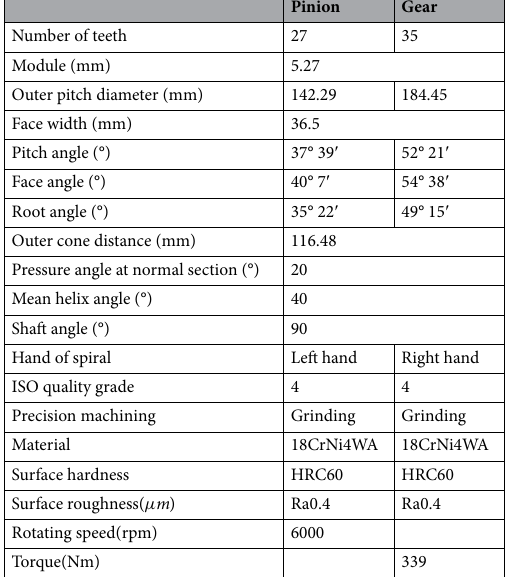
Table 2. Geometry and working parameters of the example of spiral bevel gear pair.